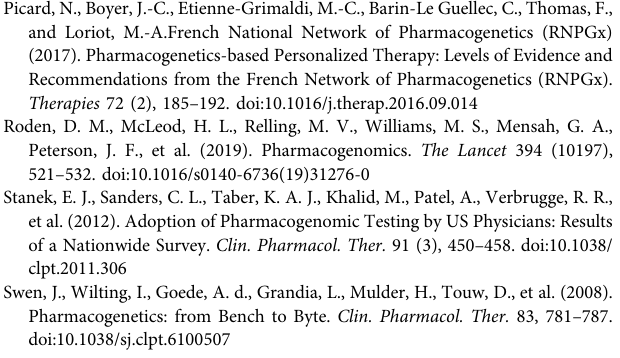
Table of Pharmacogenomic Biomarkers in Drug Labeling. (2021). Available at: https://www.fda.gov/drugs/science-and-research-drugs/table-pharmacogenomic-